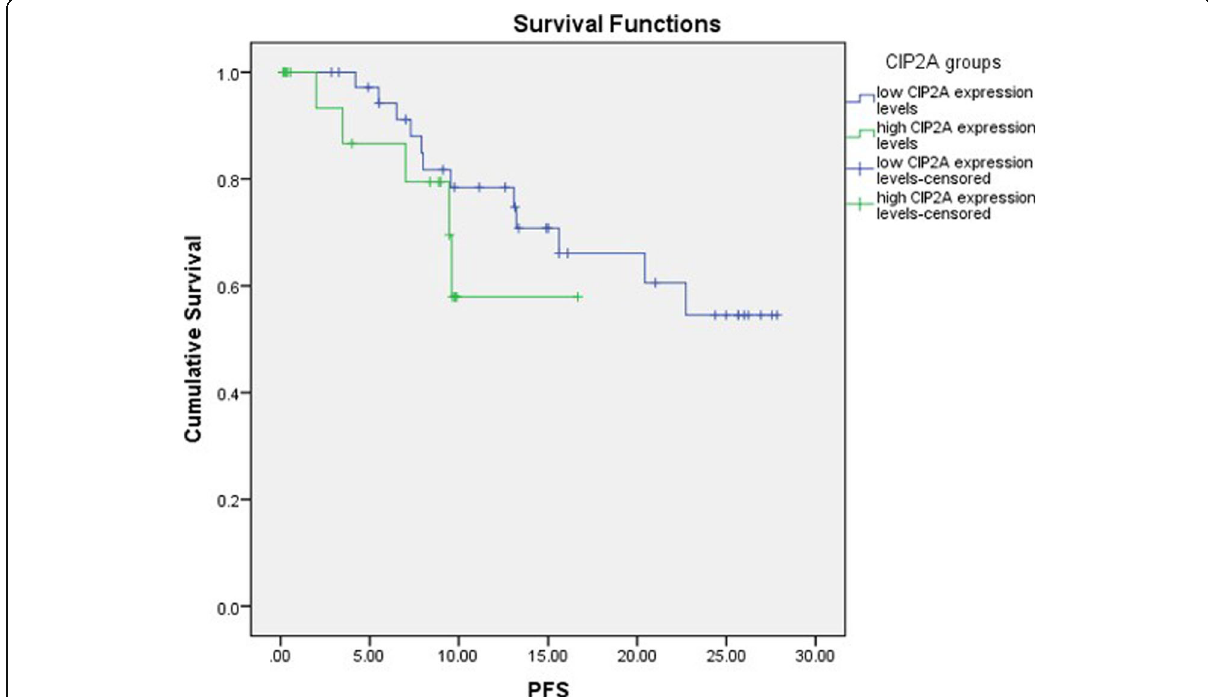
Fig. 1 Progression-free survival in patients with acute myeloid leukemia and high or low levels of CIP2A